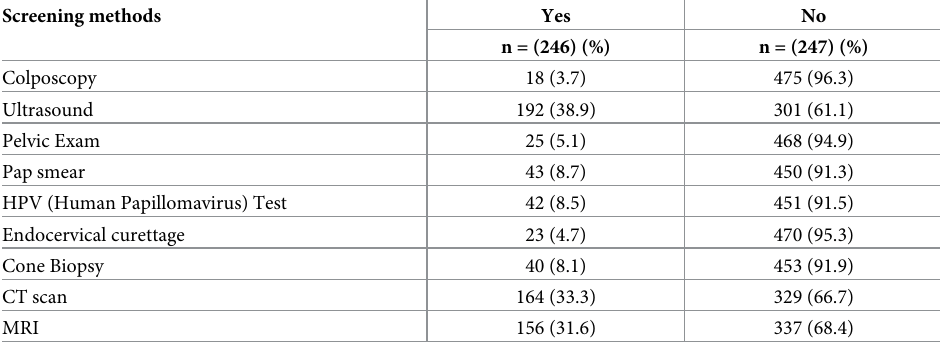
Table 4. Participants knowledge about the screening methods of cervical